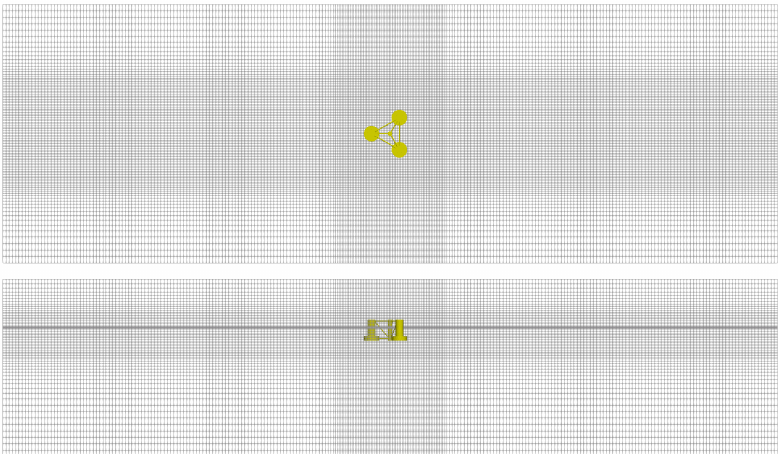
Figure 14. Computational grid for the simulation of a moored, floating offshore wind turbine in